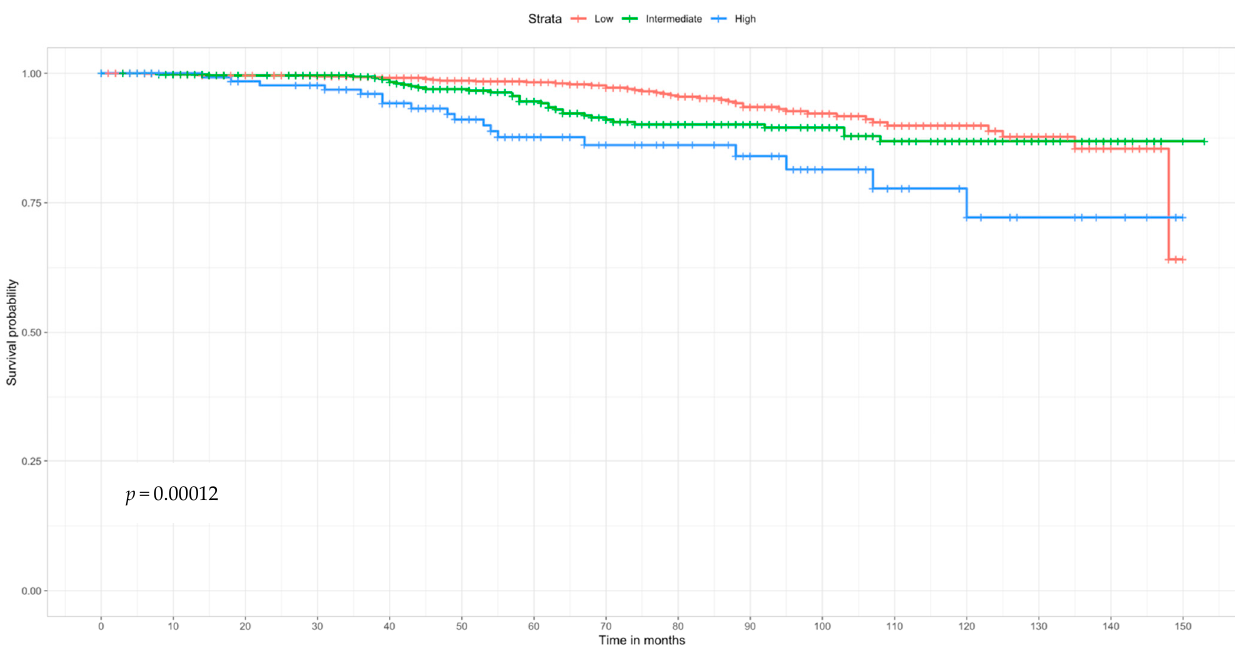
Figure 3. Kaplan–Meier curve of all Latina/Hispanic women who received ODX testing by risk group ( n = 1608).